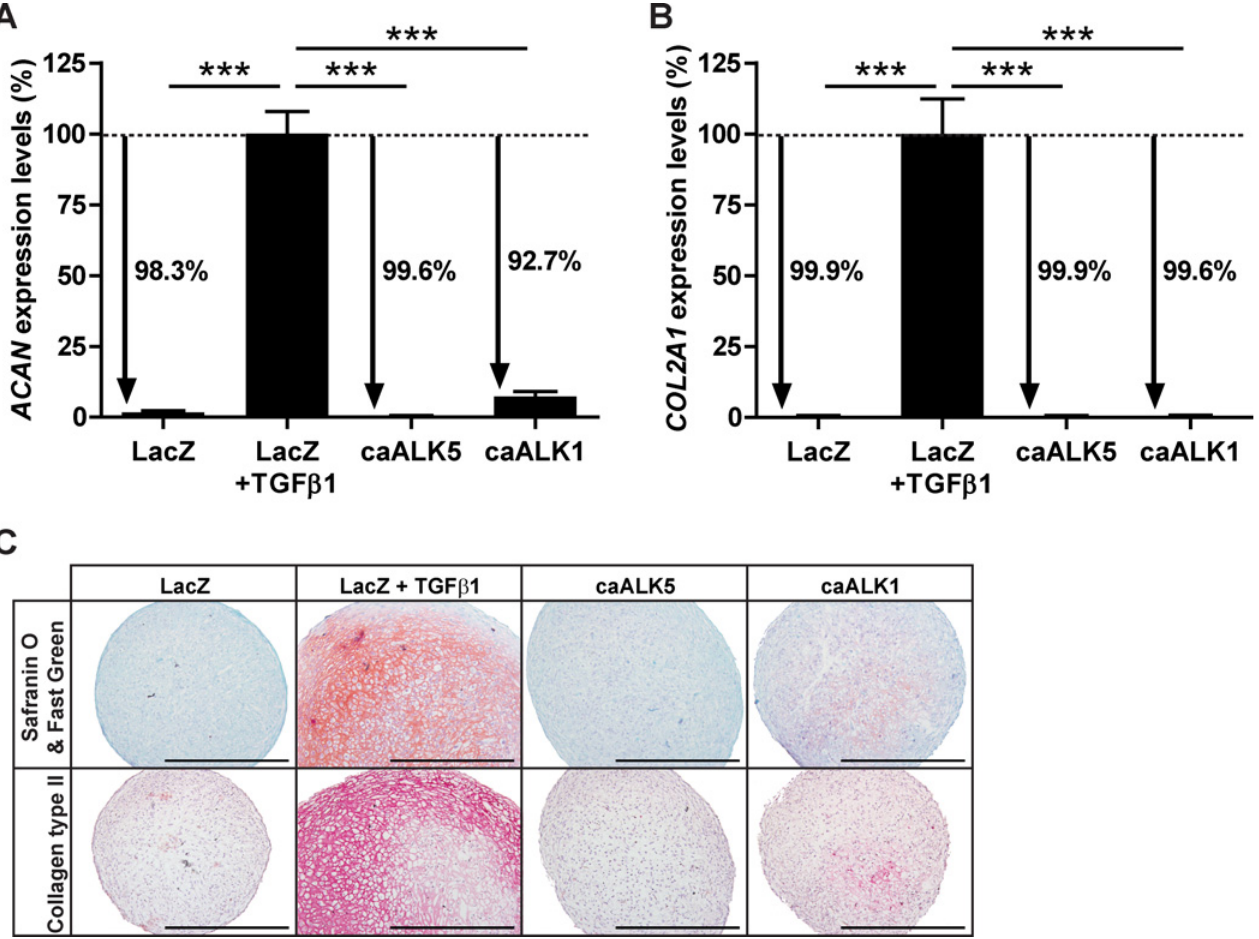
Fig 4. Constitutively active (ca) caALK5 and caALK1 receptors do not induce BMSC chondrogenesis as efficiently as TGF β does. Human fetal BMSCs (donor F1) transduced with adenoviral caALK5, caALK1 or LacZ as control were pellet-cultured in chondrogenic medium for 7 days. Only LacZ- transduced pellets were exposed to TGF β to compare if either caALK5 or caALK1 induced chondrogenesis as efficiently as induced by TGF β . Chondrogenesis was evaluated by cartilage-specific gene expression analysis of ACAN (A) and COL2A1 (B) and by staining proteoglycans with Safranin O/ Fast Green (C; upper panel) and collagen type II with immunohistochemistry (C; lower panel) . Representative images of consecutive pellet sections per condition are shown and the scale bar represents 500 μ m. Gene expression was normalized to reference gene RPS27a and data are expressed as % relative to normalized gene levels in LacZ-transduced pellets stimulated with TGF β . Bars represent mean ± SD from quadruplet pellets of 1 representative experiment (out of 3), *** p <